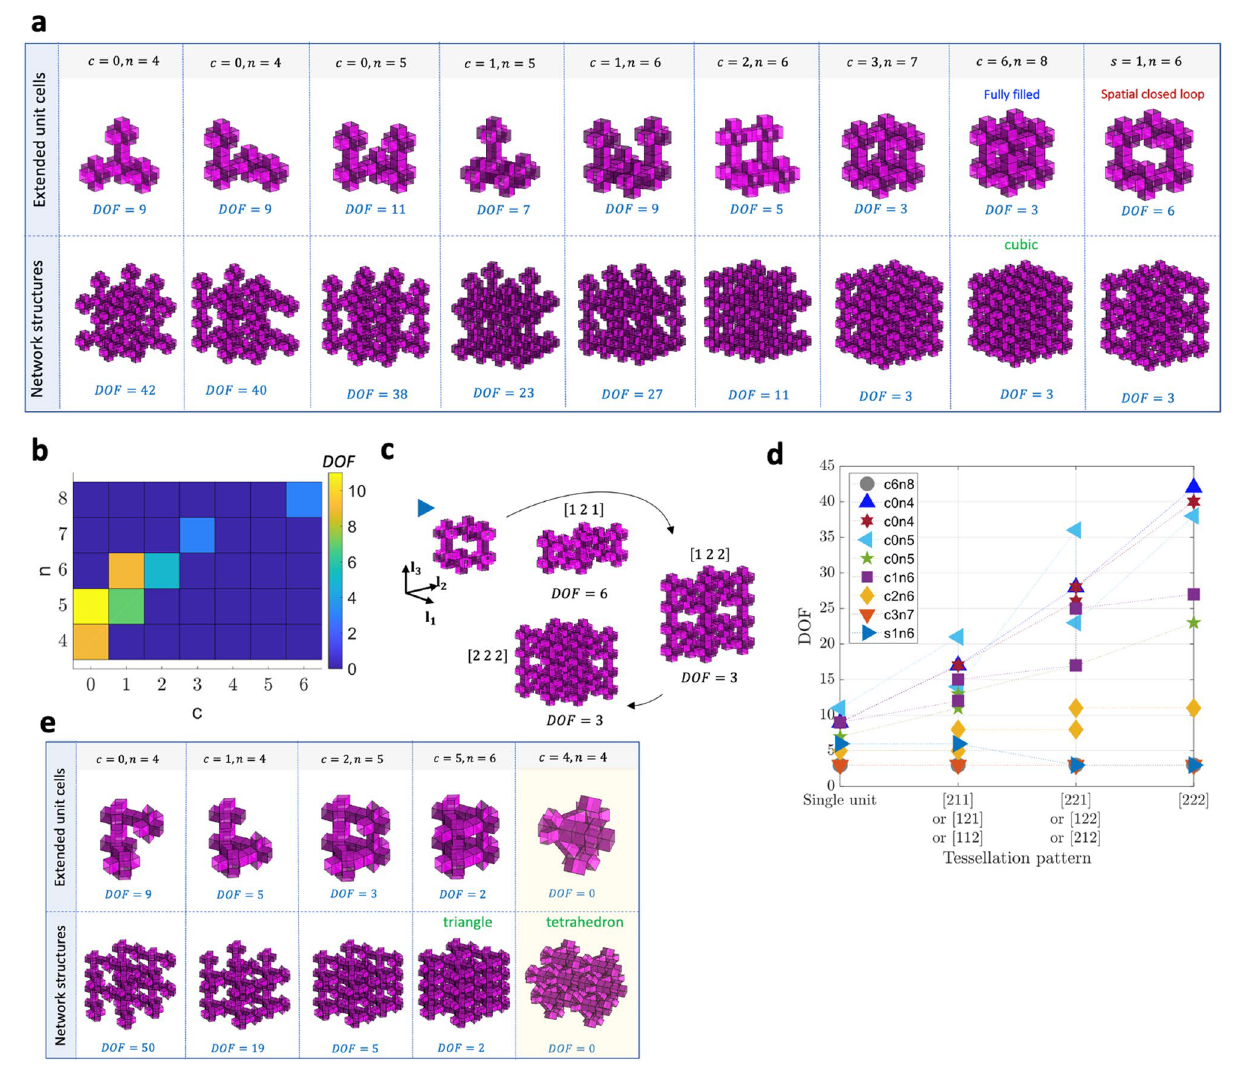
Figure 4. Mobility of 3D extended unit cells and network structures with cubic-Snapology units; n and c denote the numbers of units and loops, respectively, and s denotes the number of spatial loops. ( a ) Configurations and mobility of extended unit cells and network structures for cubic packing; ( b ) a phase map of mobility of the 3D extended unit cells for varying n and c ; ( c ) tessellation of an extended unit cell containing a spatial closed-loop along three lattice vectors l 1 , l 2 , and l 3 . Note that [ 121 ] , [ 122 ] , and [ 222 ] are the index forms to identify the number of extended units along the lattice vectors. For example, [121] represents a tessellation pattern with one unit, two units, and one unit along the l 1 , l 2 , and l 3 directions, respectively; (d) mobility of cubic assemblies of extended unit cells, where X and Y in the legend cXnY denote the number of loops and units of assemblies, respectively; ( e ) configurations and mobility of extended unit cells and network structures for triangular and tetrahedron packing. The MATLAB code for the computation of mobility of network structures is available in the